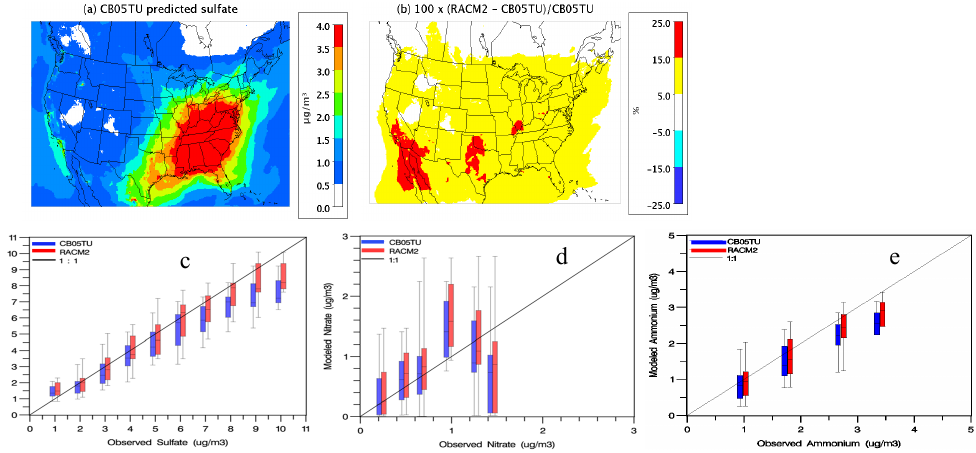
Figure 10: (a) Predicted mean sulfate obtained with CB05TU (b) percent differences in mean sulfate between RACM2 and CB05TU Fig. 9. A comparison of ozone production efficiency with values derived from observations from the Southeastern Aerosol Research and (c) a comparison of predicted sulfate to measurements from the CASTNET sites (d) a comparison of predicted nitrate to measurements from the CASTNET sites (e) a comparison of predicted ammonium to measurements from the CASTNET sites. Characterization network sites: (a) Yorkville, Georgia; (b) Centreville, Alabama; (c) Oak Grove, Mississippi.